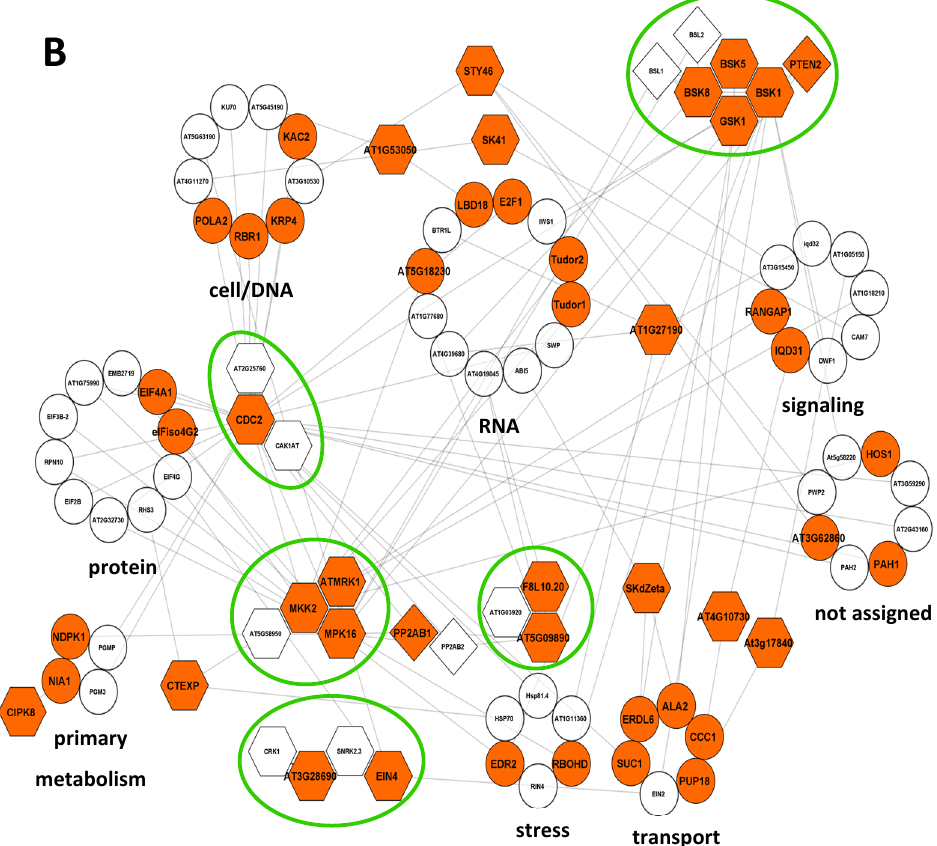
Figure 8. Association networks of phosphoproteins identified in 24 h-imbibed seeds. ( A ) Interactions of phosphoproteins identified in 24 h DI and LI seeds retrieved from STRING analysis (see Table S8 for complete data). Interactions with a confidence cut-off over 0.4 were selected and used for network construction in Cytoscape. The network was rooted onto identified kinases (hexagons) and phosphatases (diamonds). Phosphoproteins were grouped based on MAPMAN categorization. White symbols: phosphoproteins identified in DI and LI seeds; orange symbols: phosphoproteins identified only in LI seeds; green symbols: phosphoproteins identified only in DI seeds. ( B ) Simplified network including protein kinases specifically phosphorylated in 24 h LI seeds and their first-order interactors. Edges indicate direct interactions with kinases specifically phosphorylated in 24 h LI seeds. Phosphoproteins with enlarged labels were found specifically phosphorylated in LI